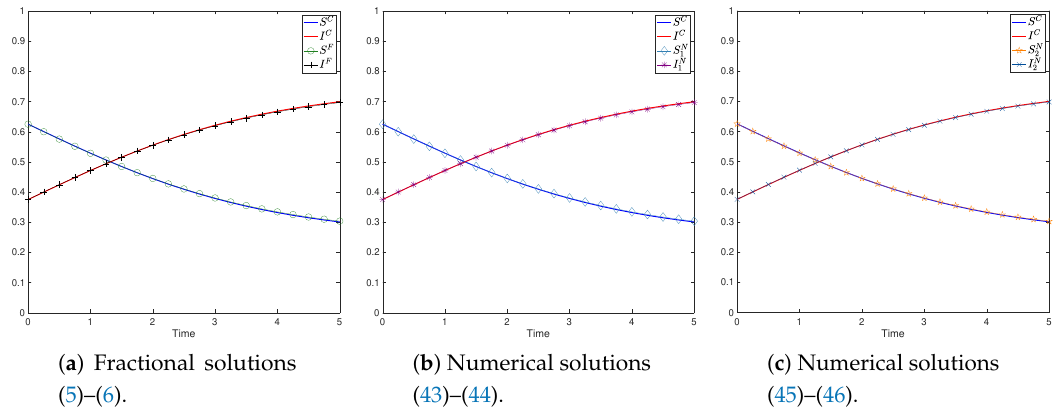
Figure 1. Comparison between the solutions to the susceptible-infectious-susceptible (SIS) model and the explicit and numerical fractional solutions to (1) with α = 0.99. The analysis shows correspondence between SIS model and the case α = 1 of our model. This result was expected, and it confirms the continuity wit respect to α (see